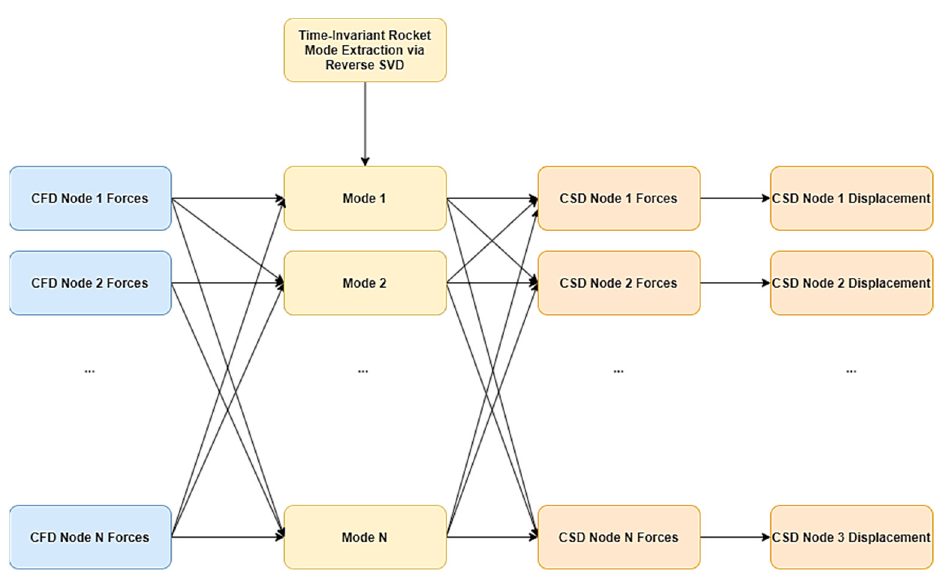
Figure 7. Overview of the MPR method.